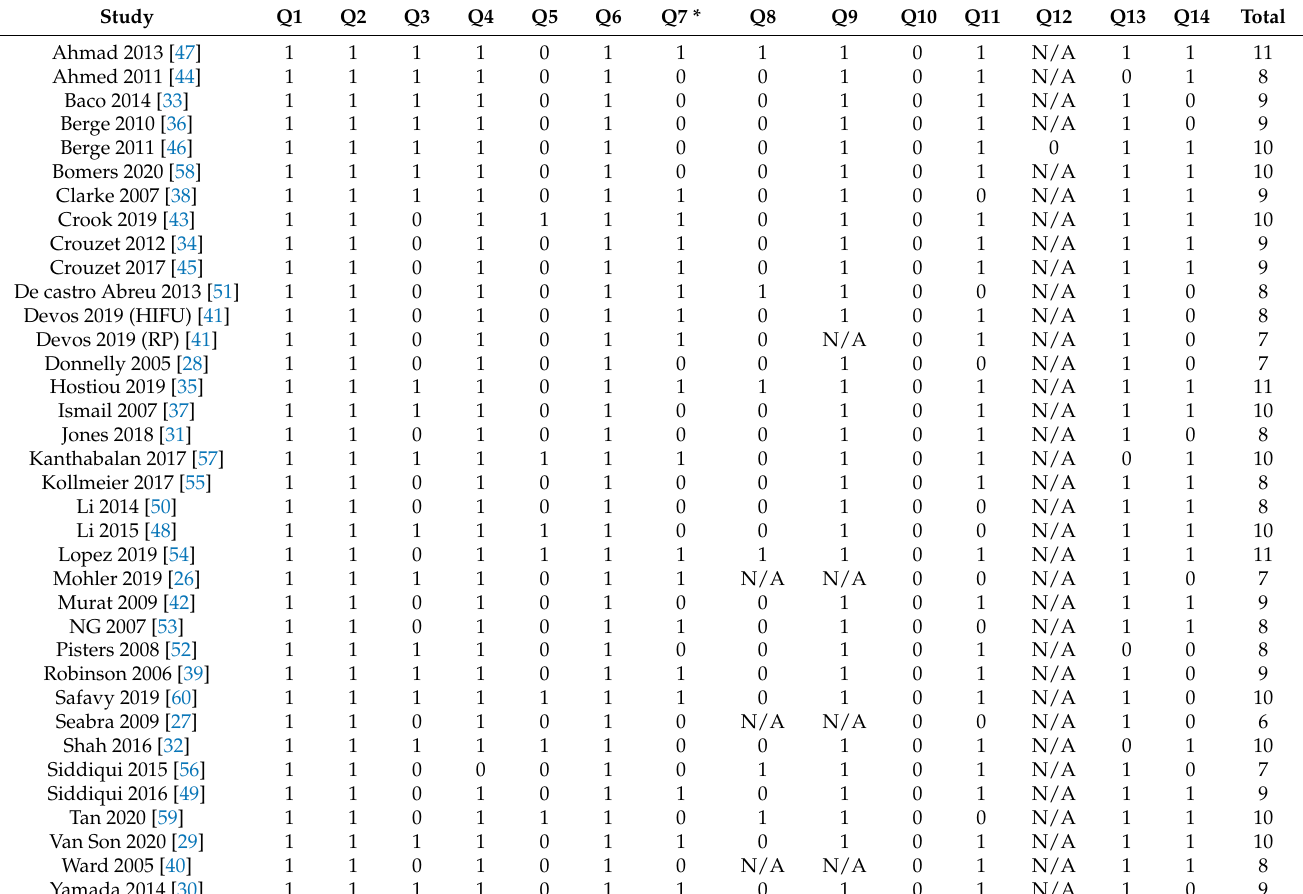
Table 4. Risk of Bias assessment of included studies using the Quality Assessment Tool for Observational Cohort and Cross-Sectional Studies,